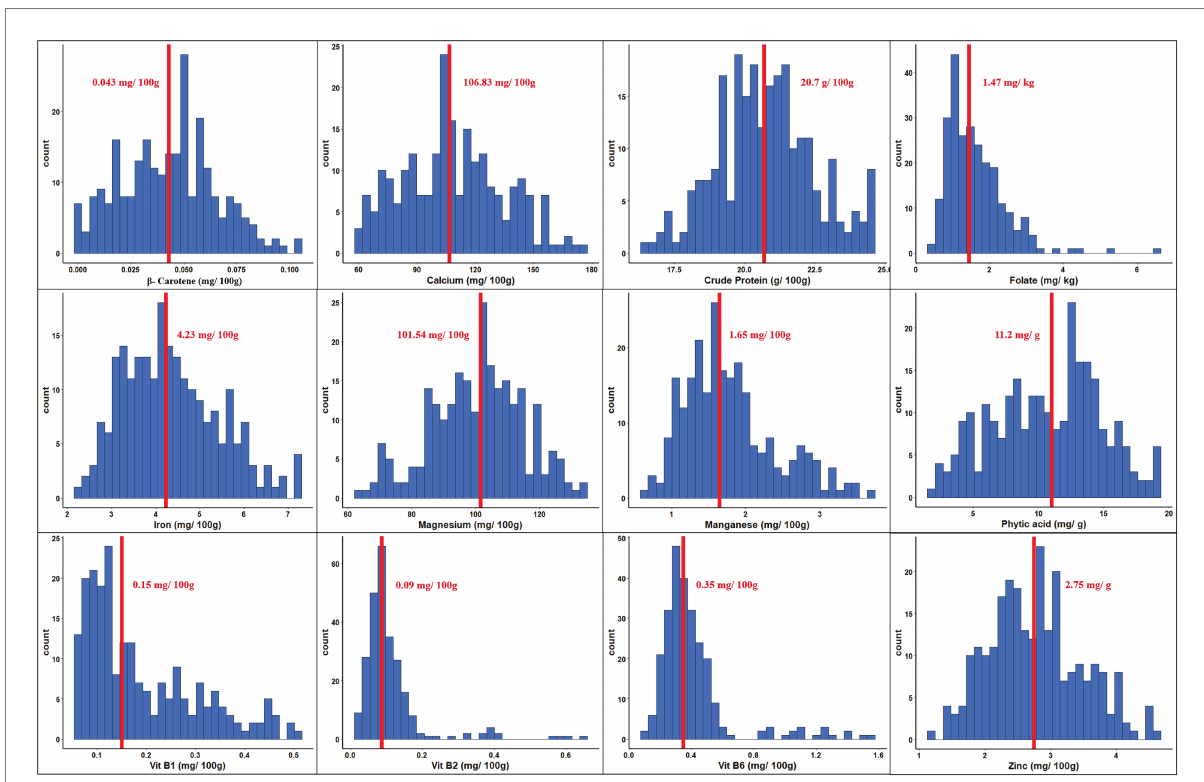
FIGURE 1 Phenotypic variation for 12 nutritional traits assayed within the chickpea reference set. Within each histogram plot, bold dashed line represents the median. The range and median for each trait are specified in the respective